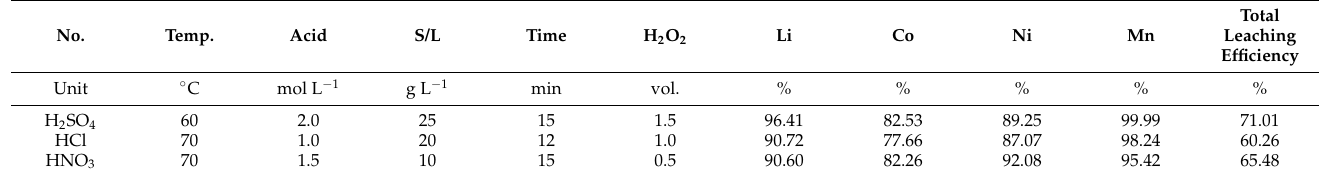
Table 6. The leaching rate of each metal under the optimal